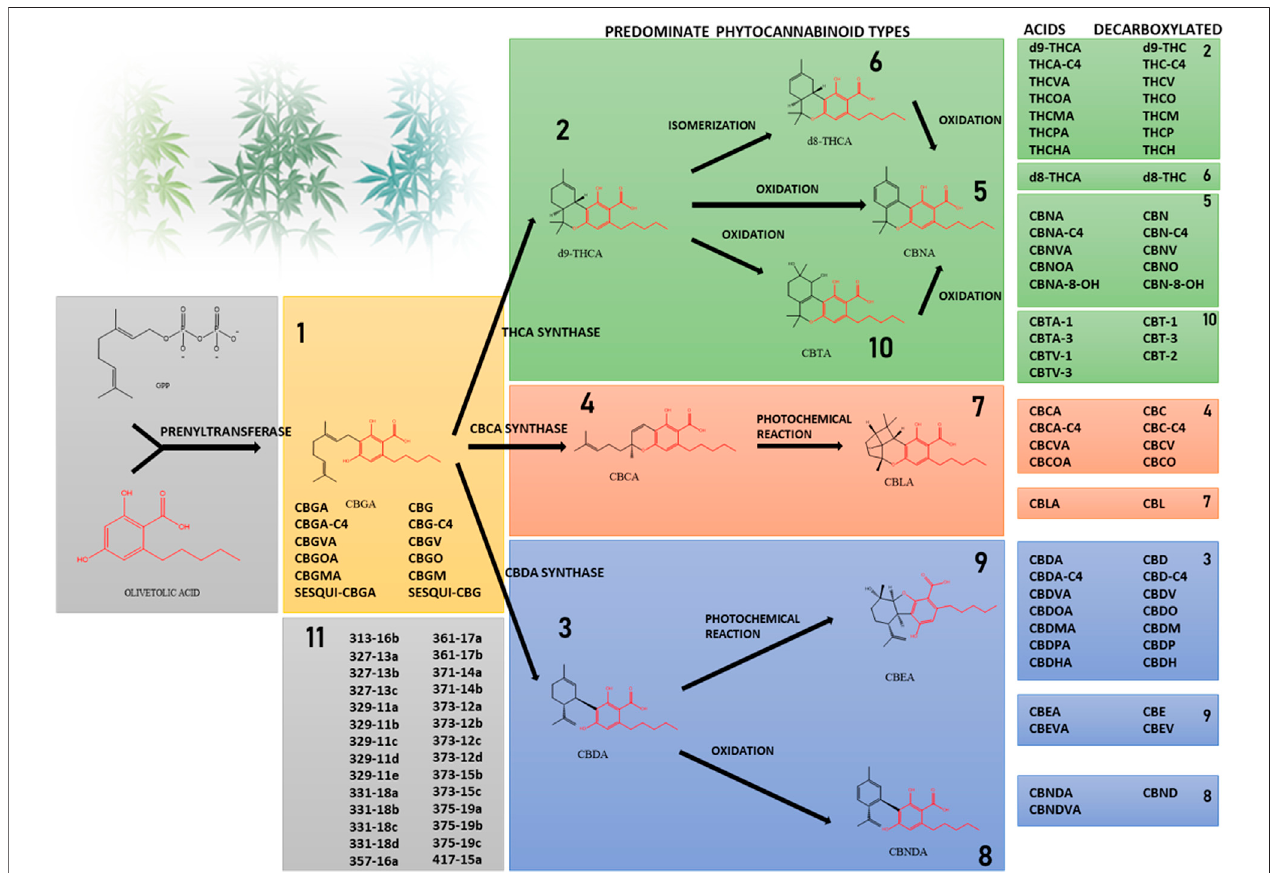
FIGURE 1 | Phytocannabinoids are divided into subclasses according to their structure. Prenylation of olivetolic acid with the isoprenoid geranyl pyrophosphate formsCBGA.Lessfrequently,insteadofolivetolicacidothermoleculeswithdifferentlengthalkylside-chainserveasprecursors.TheacidformsTHCA,CBDAandCBCA are synthesized in the Cannabis plant from CBGA. The neutral forms and other subclasses of phytocannabinoids are the result of chemical processes such as decarboxylation,isomerizationandothers.Thesharedcoreofolivetolicacidbythedifferentsubclassesisdepictedinred.Subclass11includesphytocannabinoids identi fi ed by mass spectrometry in different Cannabis chemovars, whose structures have not been elucidated yet.